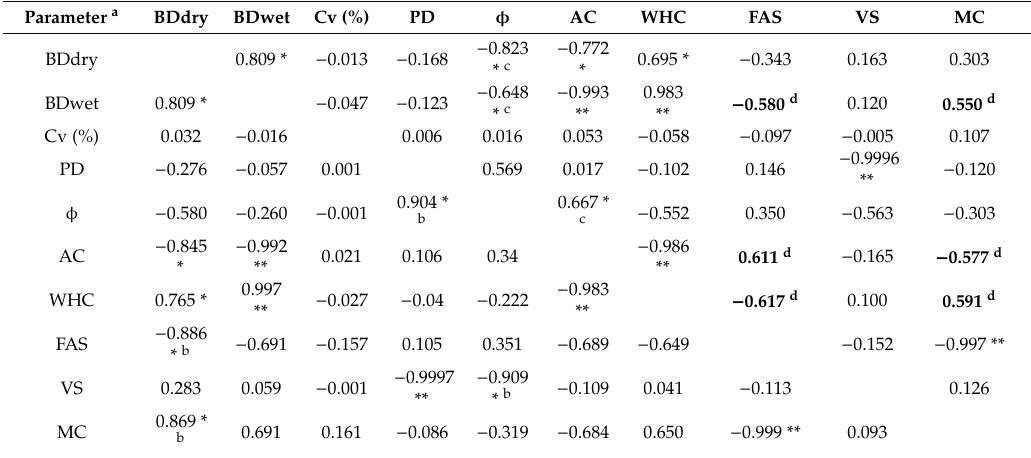
Table 5. Coe ffi cients R 2 for linear regression between